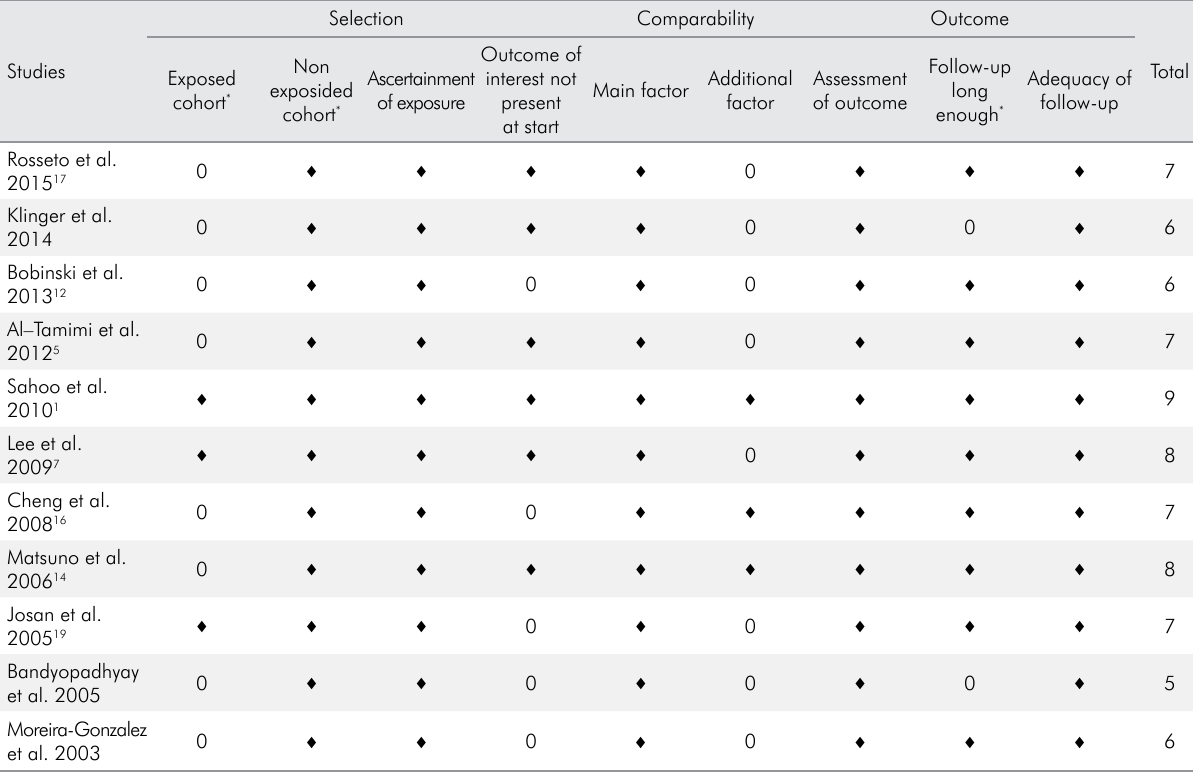
Table 1. Newcastle-Ottawa